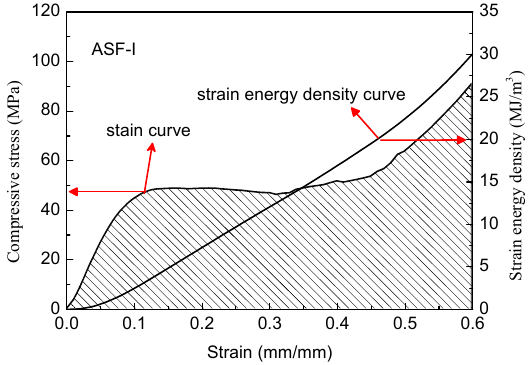
Figure 12. Stress–strain curve and strain energy density curve of ASF-I.